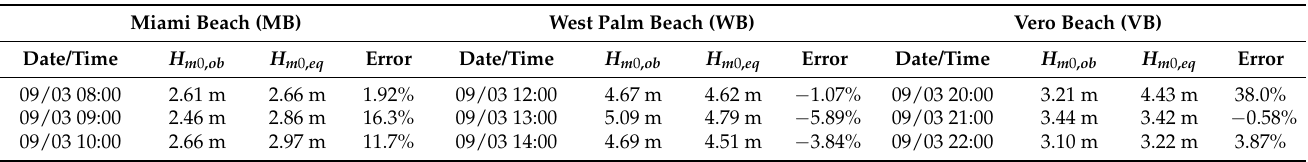
Figure 7. Comparisons between observed ( S ob ) and modeled ( S eq ) wave spectra corresponding to times with the largest waves at ( a ) Miami Beach, ( b ) West Palm Beach, and ( c ) Vero Beach. Table 1. Summary of observed ( H m 0, ob ) and predicted ( H m 0, eq ) significant wave heights for MB, WB, and VB corresponding to times with the largest waves as presented in Figure